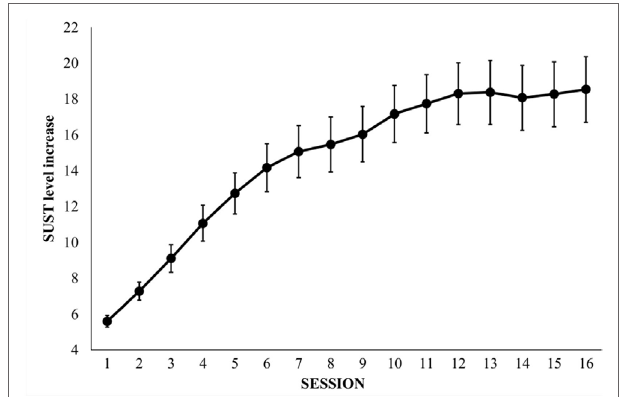
FigUre 2 | Level increases over 16 training sessions for the SUS training task in the training group ( n = 31). SUS, selective updating of sentences.